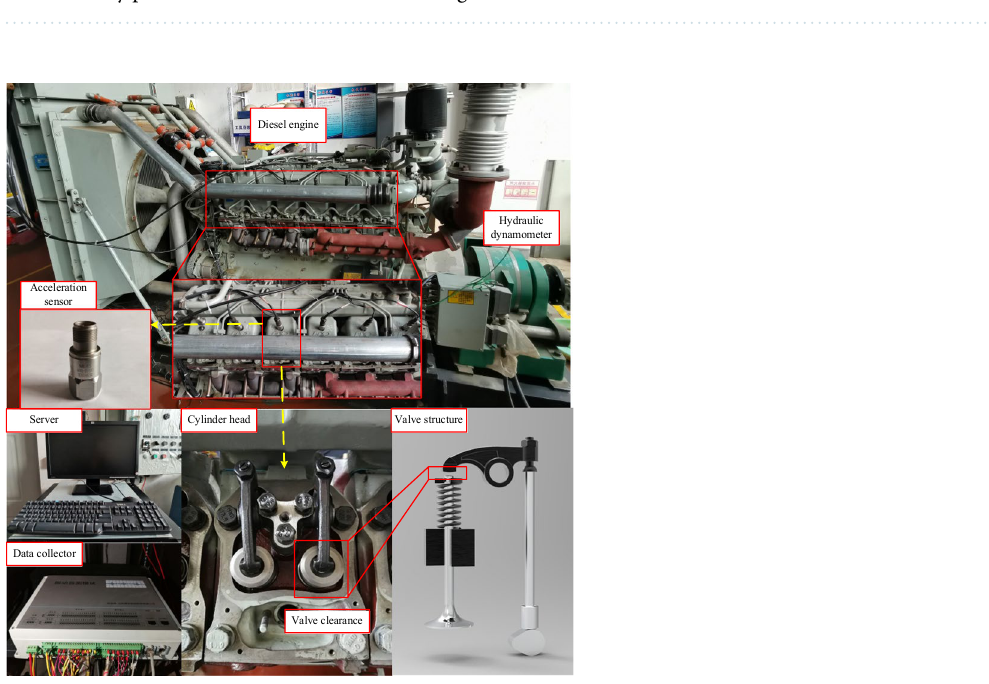
Table 2. Key parameters of TBD234V12 diesel engine.